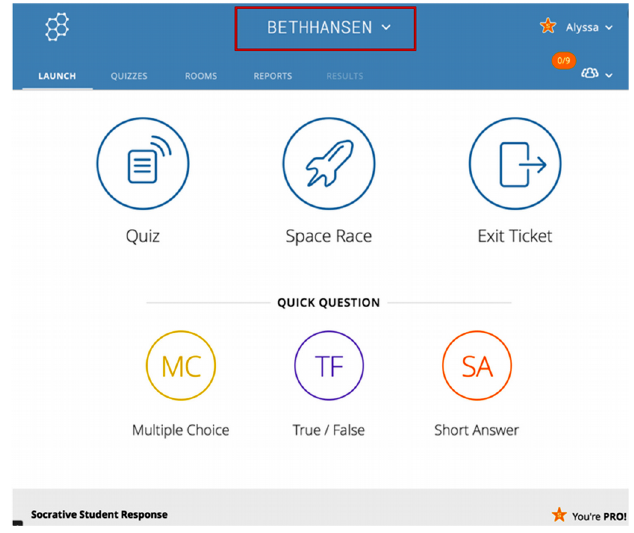
Figure 1. Type of questions on the socrative